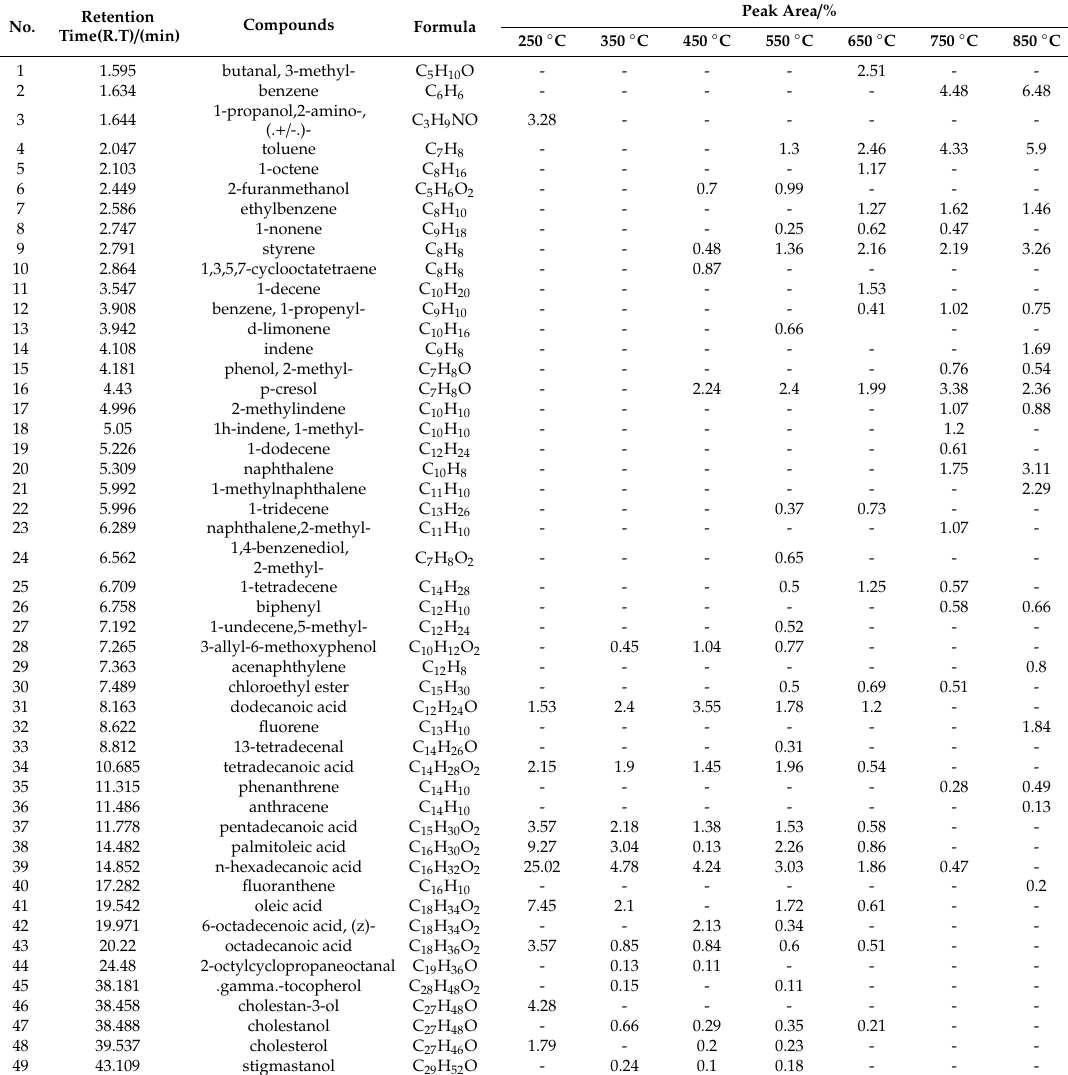
Table 2. Detailed analysis of Total Ions Chromatograph (TIC) chromatogram of the evolved gas at di ff erent